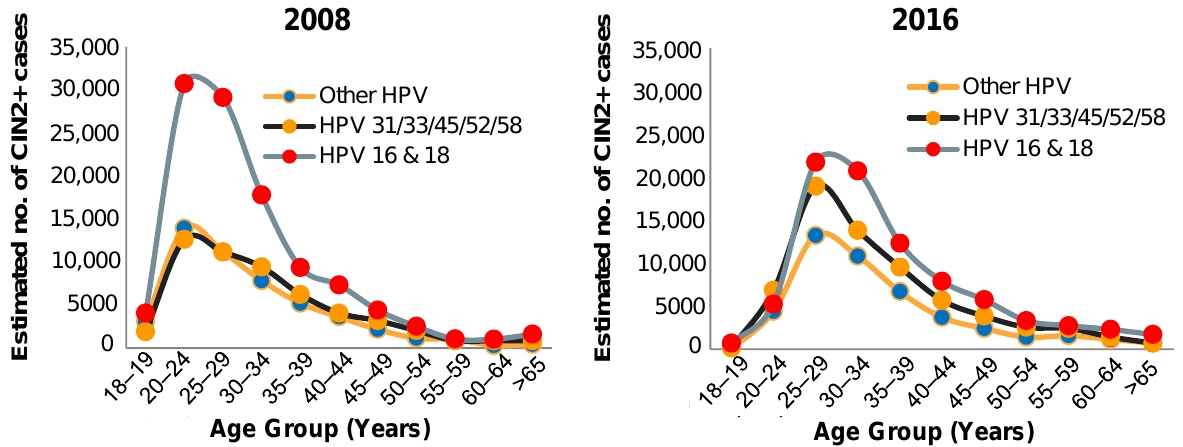
Figure 3. Estimated number of diagnosed CIN2+ cases by HPV type and age group in United States from 2008 to 2016.